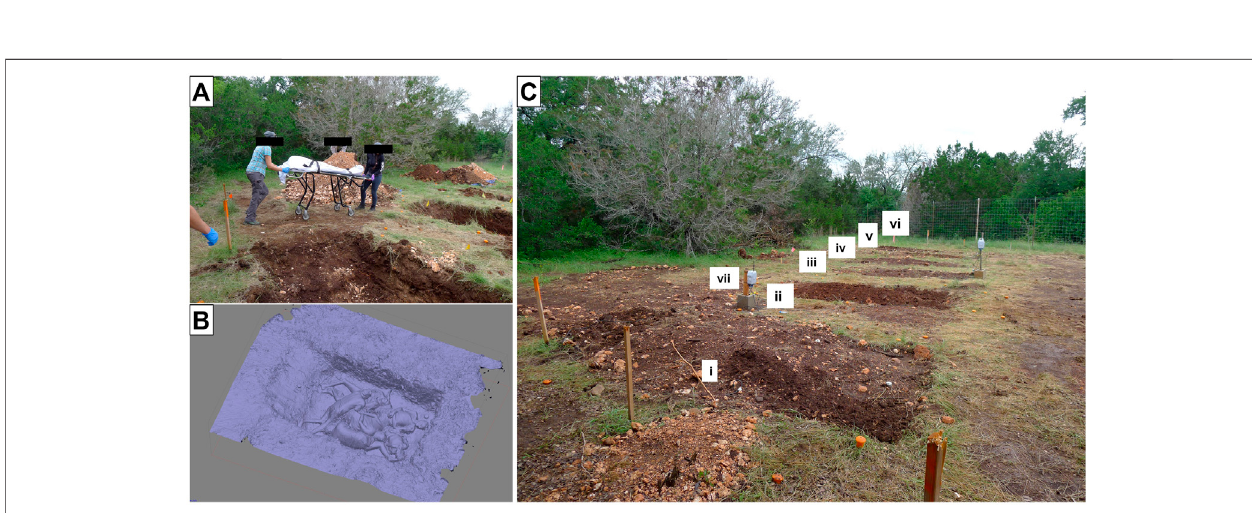
FIGURE 2 | Experimental setup with (A) excavated graves and human remains being wheeled to the site, (B) a 3D model of the mass grave with six human cadavers created from photos, (C) outline of all six graves with (i) the control mass grave with no human cadaver, (ii) mass grave with six human cadavers deposited randomly, (iii, iv, and v) individual graves with one human cadaver each, (vi) control individual grave without cadavers, and (vii) one of three in situ Wi-Fi-enabled soil data